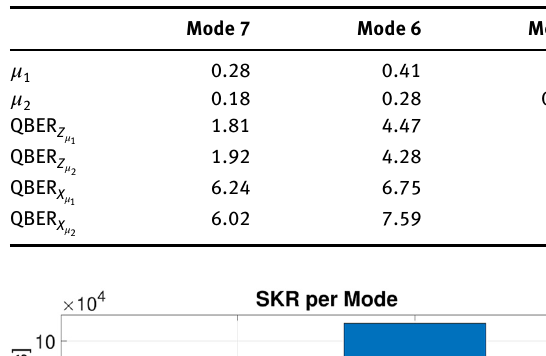
Table 2: Experimental mean photon numbers for the 3-mode multiplexing demonstration as well as QBERs and SKR attained for each mode.